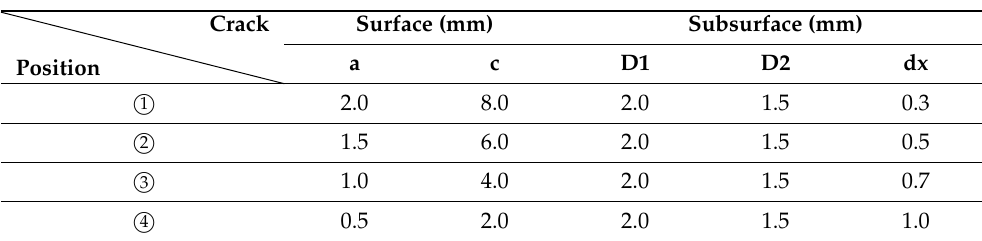
Table 4. Artificial cracks of wheel specimens.